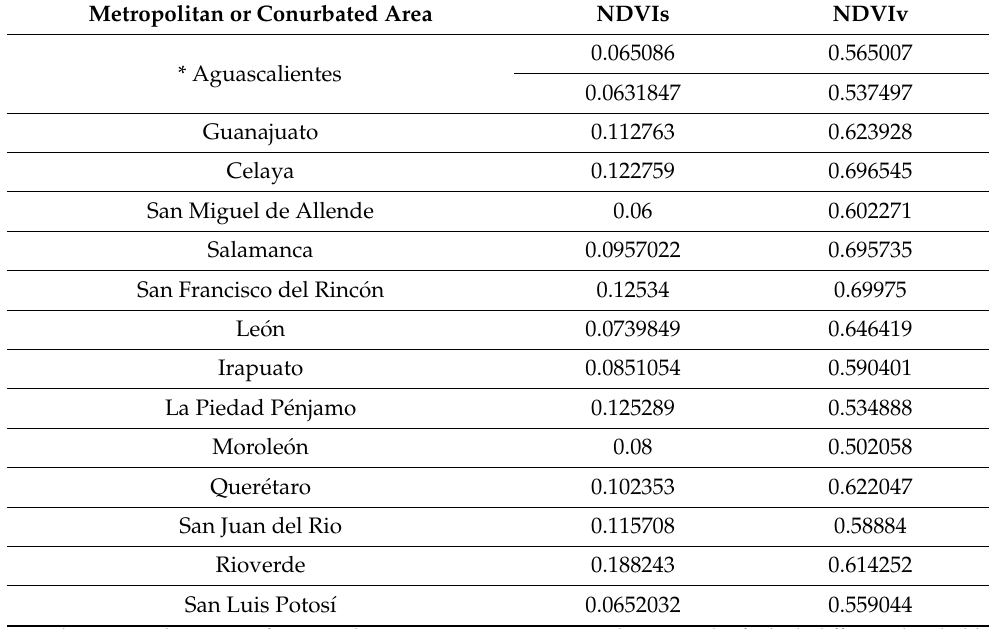
Table 2. Thresholds from NDVI for calculating surface emissivity. Metropolitan or Conurbated Area NDVIs NDVIv *